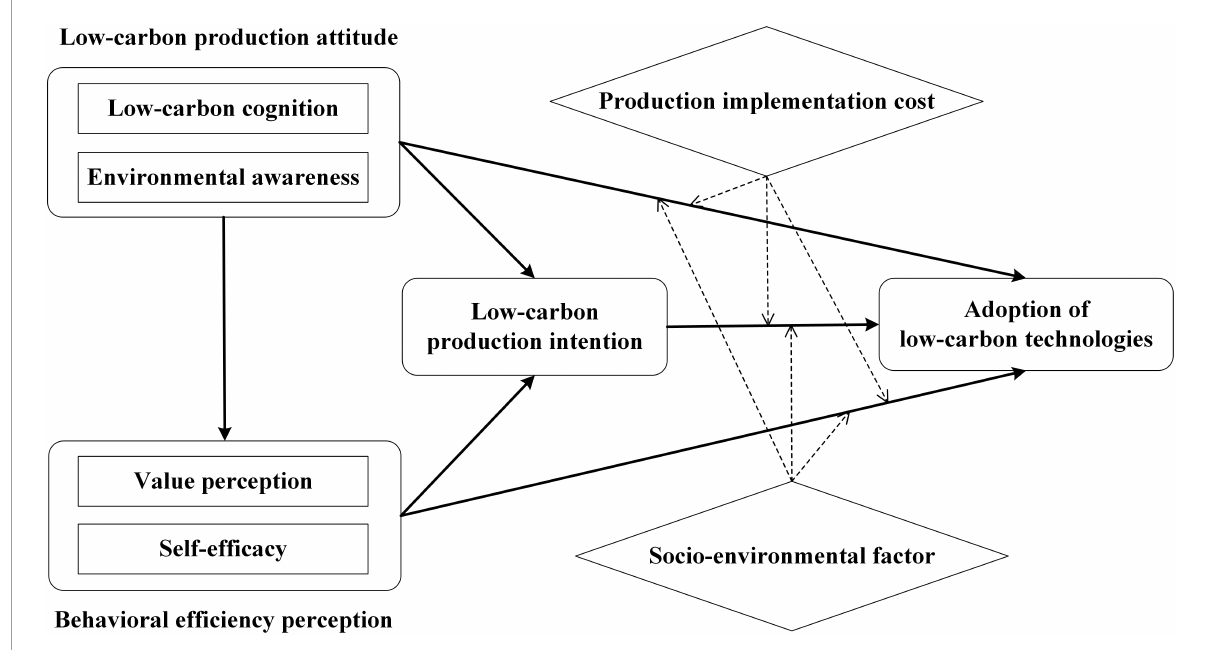
FIGURE1 Theoretical framework of rice farmers’ adoption of low-carbon technologies.